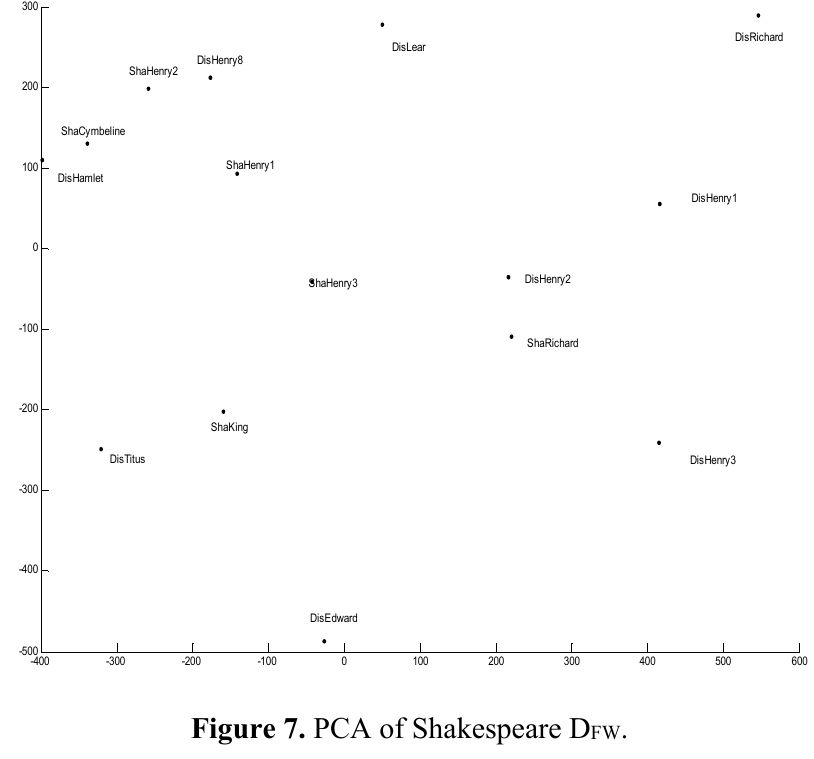
Figure 6. The hierarchical cluster analysis of Shakespeare D FW using Product-Moment correlation and Mean Proximity.